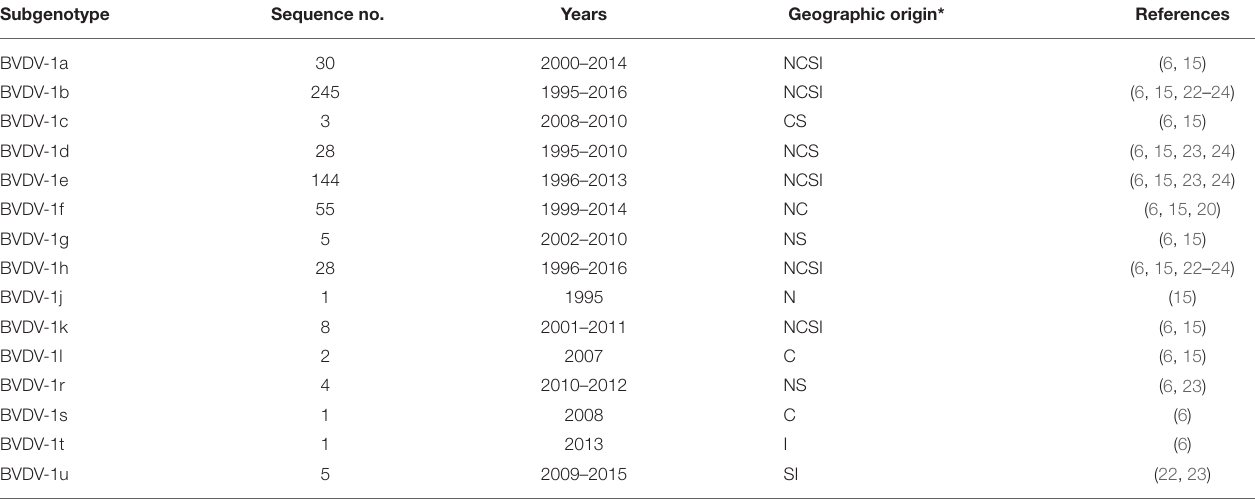
TABLE 1 | Frequency of BVDV-1 subgenotypes in cattle.